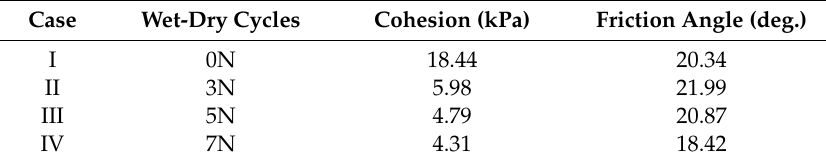
Table 6. Wet-Dry Cycle Shear Strength Values for Yazoo Clay (Soil 1 in Table